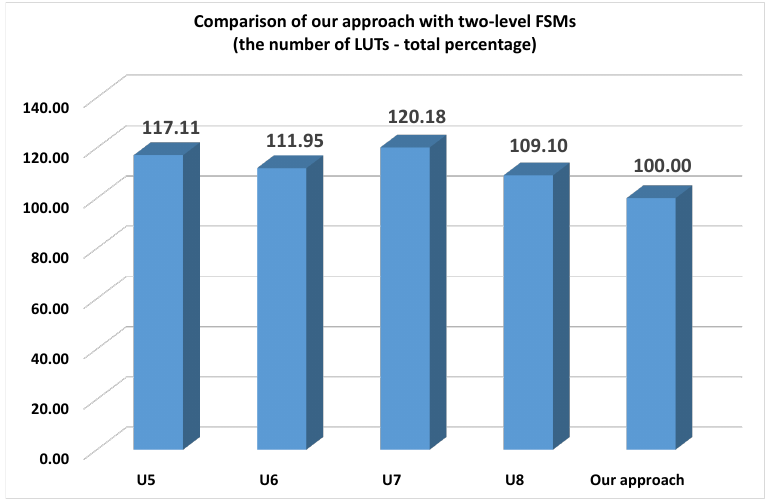
Figure 13. Comparison diagrams of our approach with two-level